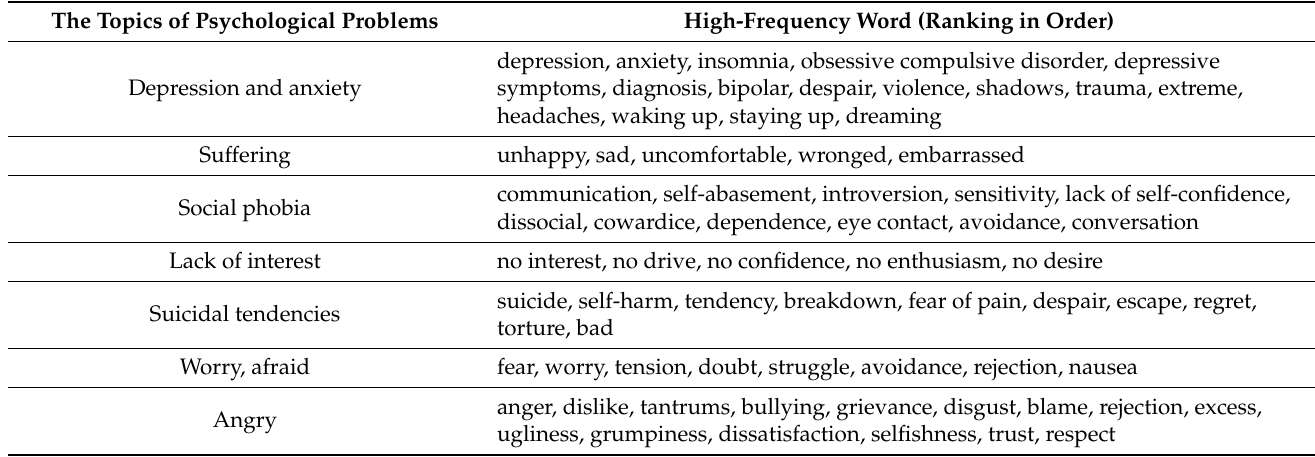
Table 1. Psychological problems related to topics of the online PHS posts.